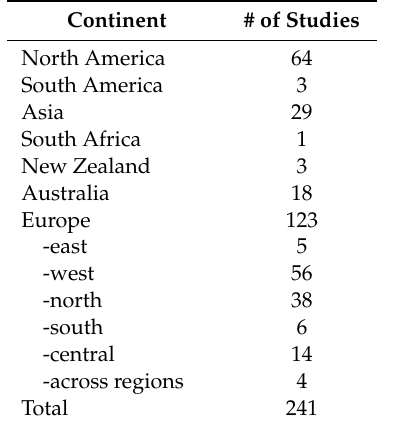
Table 4. The studies were grouped, based on the continent where the study took place (not including reviews, n =